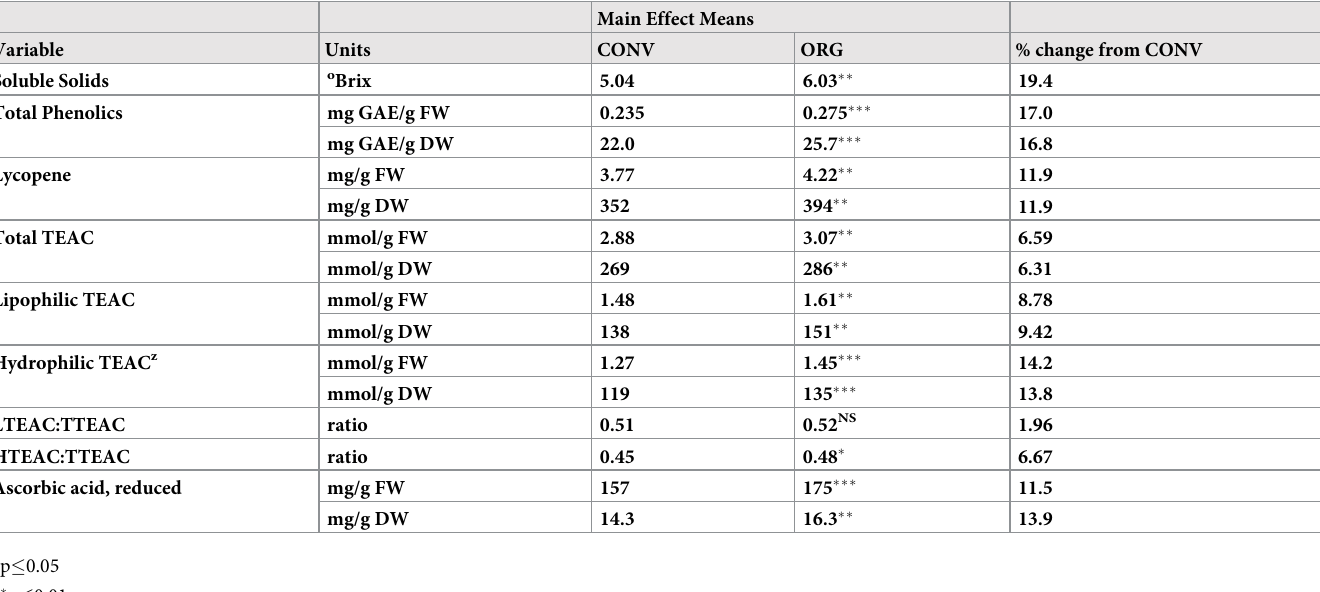
Table 1. Measured phytochemical concentration of red ripe tomato fruit. Soluble solids, total phenolics (gallic acid equivalents, GAE), lycopene, total Trolox equivalent antioxidant capacity (TTEAC), lypophilic TEAC, hydrophilic TEAC, and reduced ascorbic acid concentrations on fresh weight (FW) and dry weight (DW) bases (except soluble solids) under conventional (CONV) and organic (ORG) fertilizer treatments. Data were analyzed using SAS Mixed Model. (See Supplementary file for measured observations, LS means, standard deviation, and standard